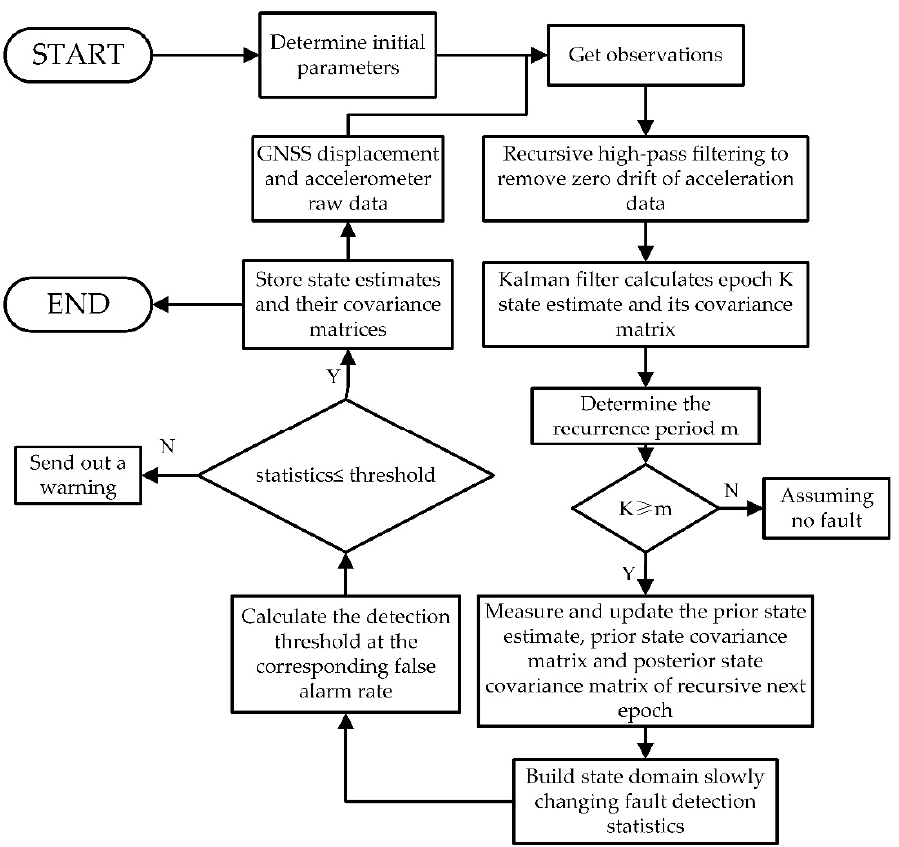
Figure 1. The flow chart of the GNSS/accelerometer integrated deformation monitoring method for slow-growing fault detection in the state domain.